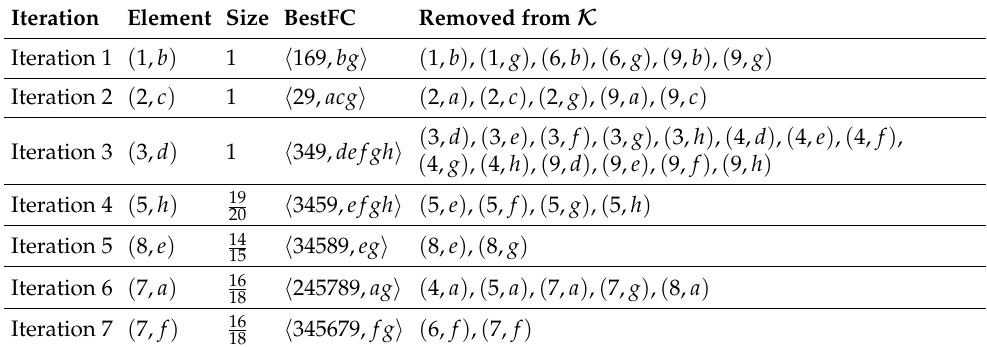
Table 5. The procedure of the C ONCISE algorithm ( δ = 1) on the formal context given by Table 1. Iteration Element Size BestFC Removed from K